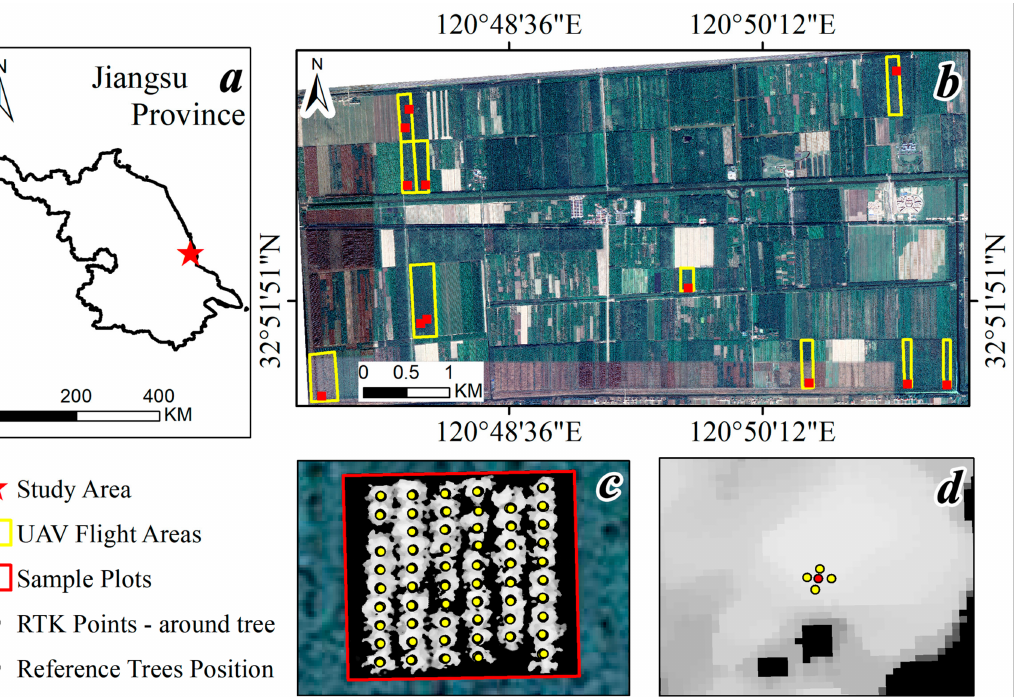
Figure 1. Study area and fieldwork design. ( a ) The study area is in the coastal area of Jiangsu province, China; ( b ) flight areas of UAV and the sample plots for fieldwork; ( c ) four RTK points were records of each tree location; ( d ) reference tree position with mean center for the four RTK points for each